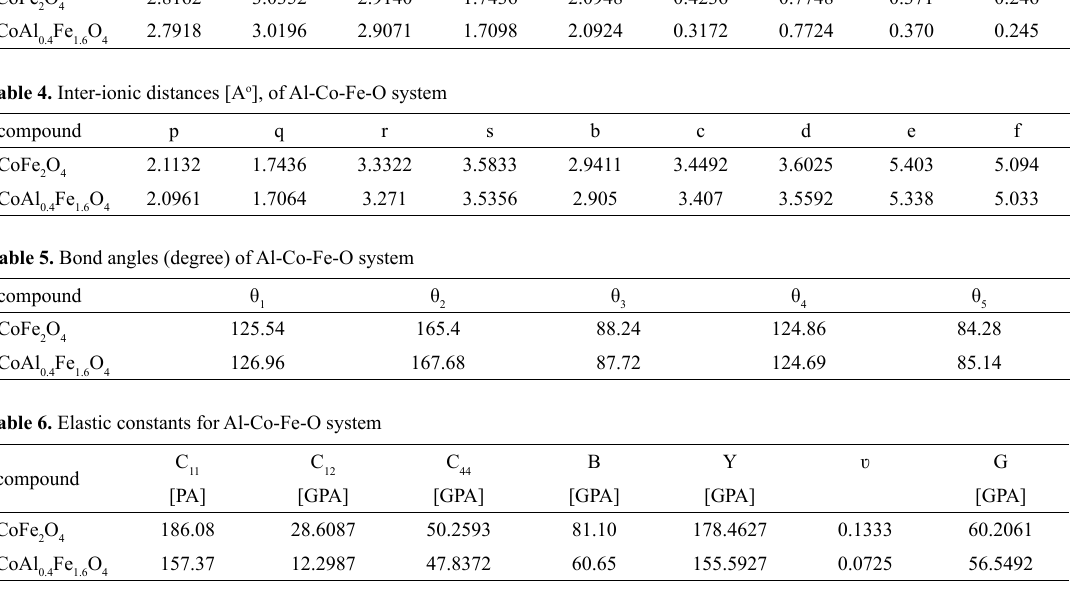
Table 3. Edge lengths [A o ], bond lengths[A o ], radius of the tetrahedral and octahedral [A o ], and anion parametes [A o ] of Al-Co-Fe-O system compound